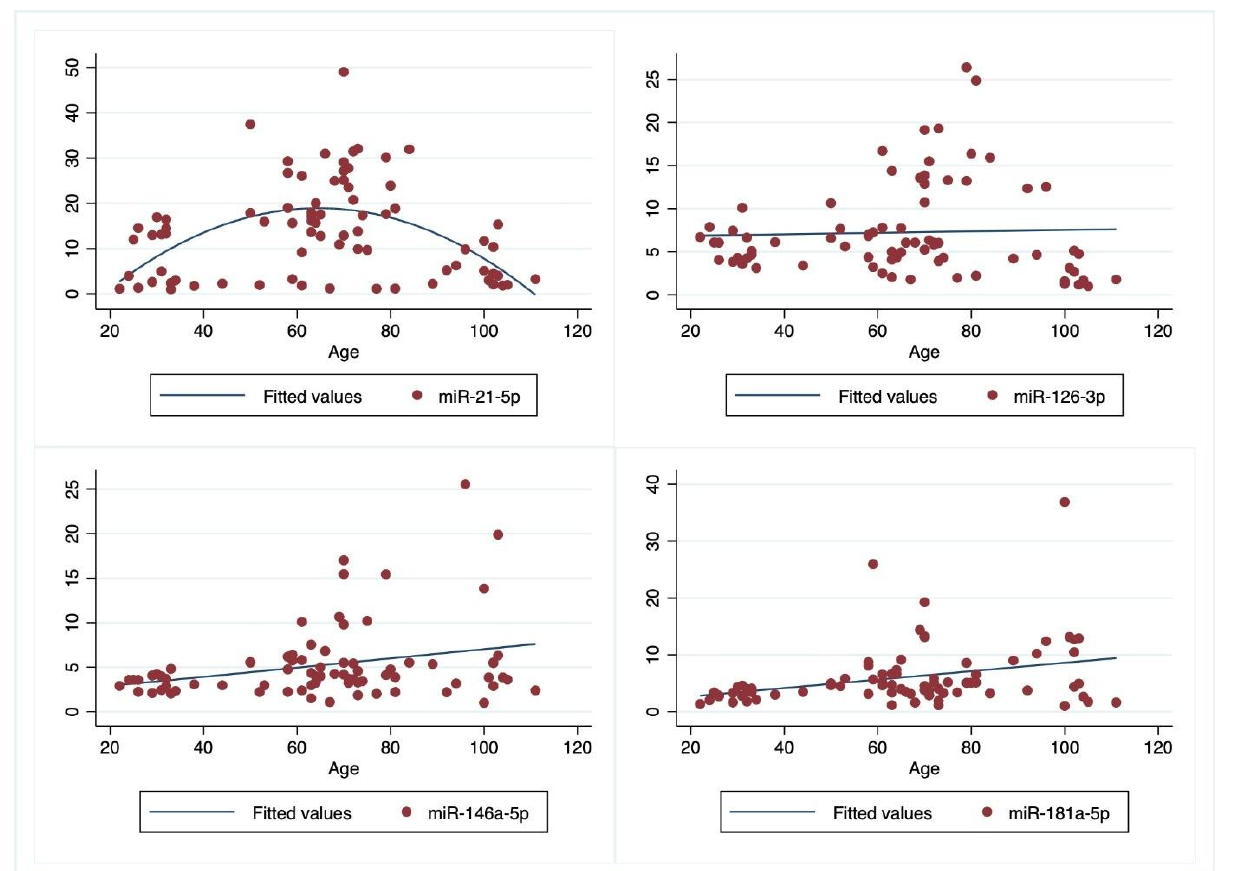
Figure 2. Scatter Plot of observed and fitted models of correlation of plasma values for miRNAs with age. Table 2. Coefficients and significance estimates of miR-21-5p.